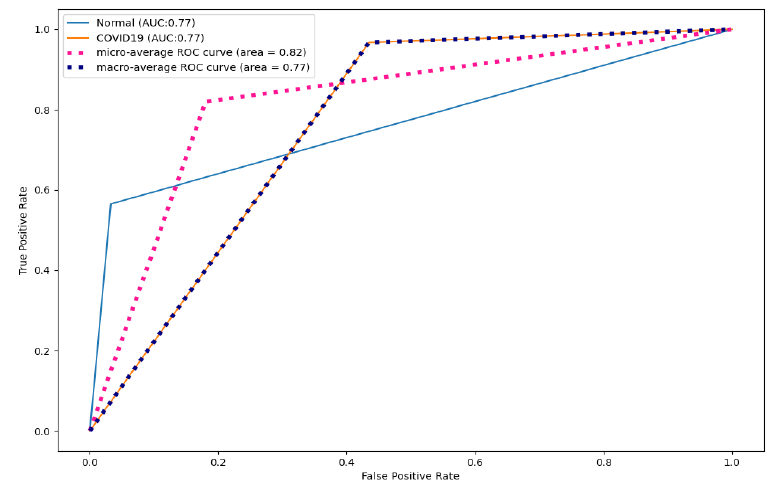
Figure 11. ResNet50 ROC curves for CT images.